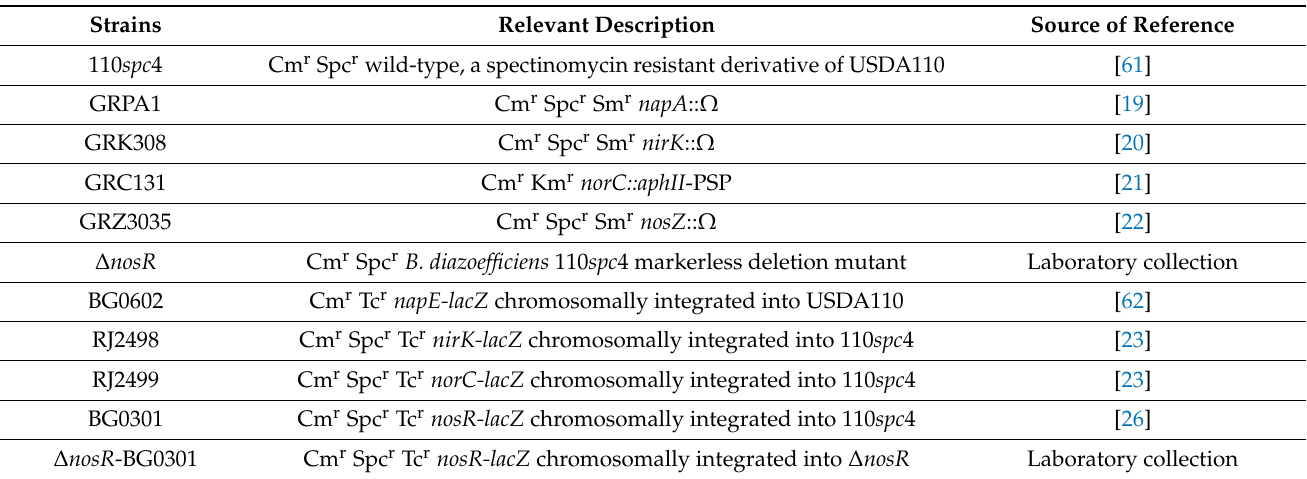
Table 1. B. diazoefficiens strains used in this